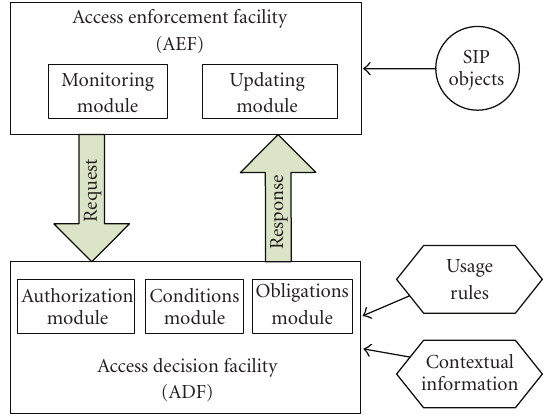
Figure 3: Conceptual structure for UCON/SIP reference